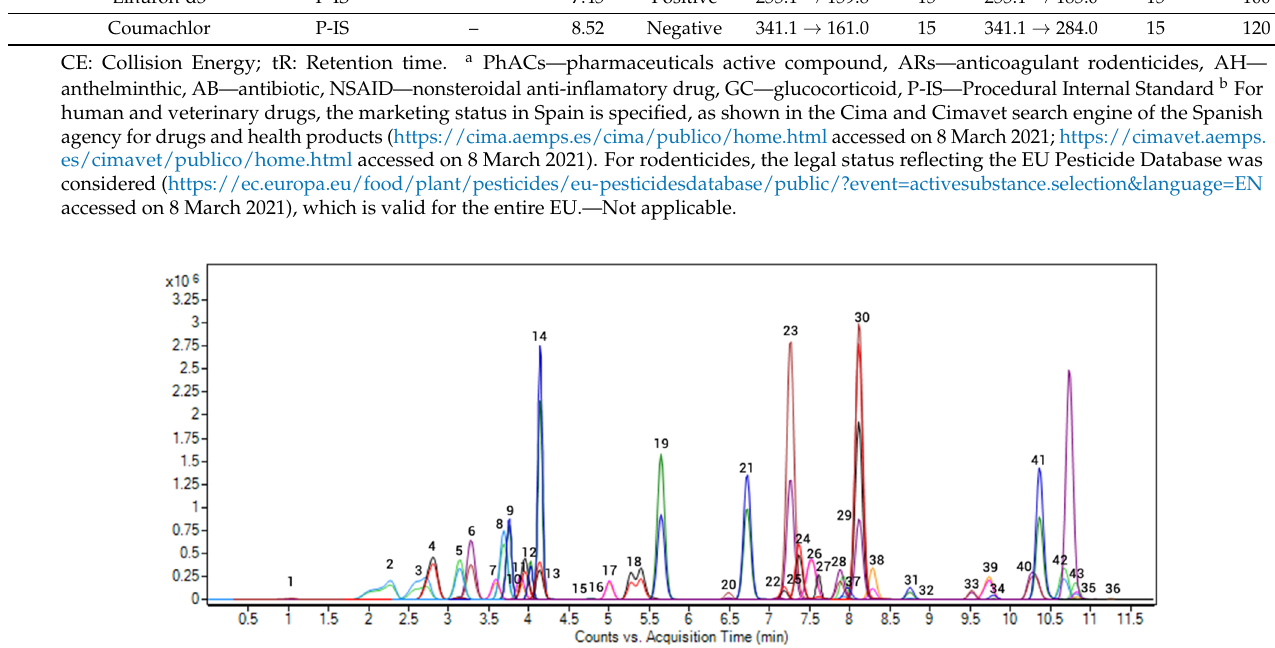
Figure 1. LC-MS/MS chromatograms of a blank soil sample spiked with the anticoagulant rodenticides (ARs) and the pharmaceutical active compounds (PhACs) at 50 ng g ⁻ 1 .